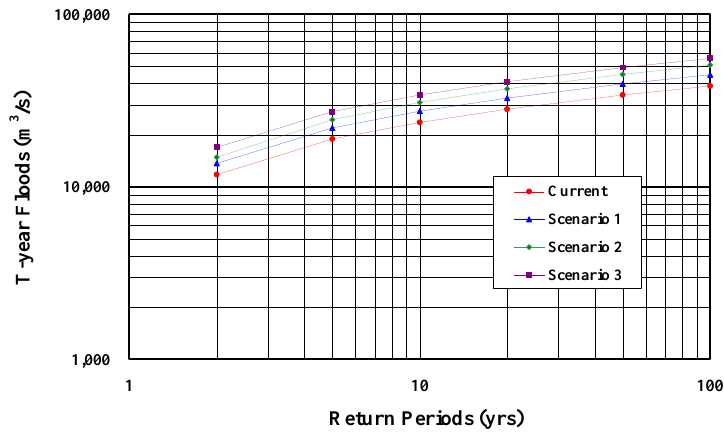
Figure 16. Flood Change for different Return periods according to the Scenarios (Hourly). T-year represents the different return period. Table 5. Percent Increase in T-year Floods according to the Scenarios (Hourly) (%). Table 6. Percent Increase in T-year Floods according to the Scenarios (Hourly) (%).